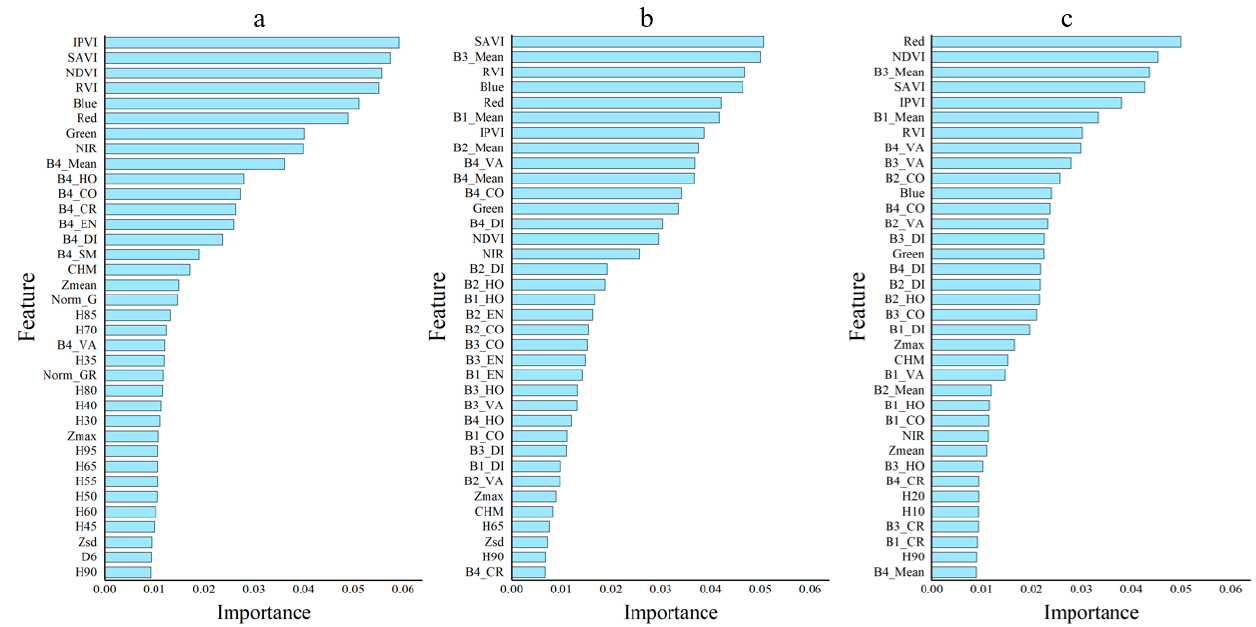
Figure 3. Feature importance rankings at different altitudes: ( a ) 1600 m; ( b ) 1800 m; ( c ) 2000 m.